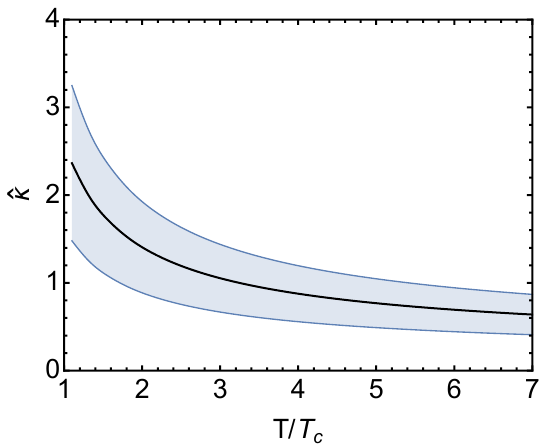
Figure 5 . Plot of ˆ κ as a function of the temperature in units of T c , where T c = 155 MeV. The plot reproduces the fit done in [37] for a set of pure SU(3) lattice data ranging from T/T c = 1 . 1 to T/T c = 10 4 . The fit function reproduces the next-to-leading order expression of ˆ κ up to the constant multiplying the ratio of the Debye mass over T , which is fitted. The shaded band includes the errors coming from varying the renormalization scale by a factor of 2 and the statistical